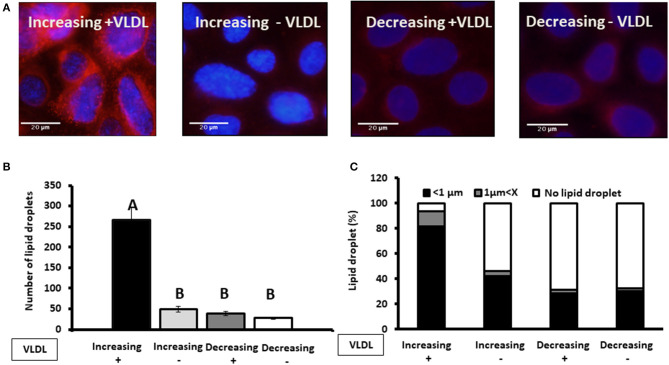
The effect of progesterone on the lipid droplet number is VLDL dependent. Mammary epithelial cells (MECs) were incubated with increasing (0.75, 2.5, and 5 ng/ml) or decreasing (5, 2.5, 0.75 ng/ml) progesterone concentration, with the presence or absence of VLDL. After incubation, nucleus was stained with DAPI (blue) and lipid droplets in Nile red (red). Lipid droplets were counted and measured. (A) Representative figures from increasing and decreasing progesterone concentration treatments with and without VLDL. The most pronounced lipid droplets were found in the increasing progesterone treatment, in the presence of VLDL. Differences between increasing and decreasing treatments were only presented if VLDL was added to the culture medium. (B) Average number of lipid droplets by treatment per field; n = 5 fields with 24–50 cells per field and 3 replicates per treatment. Highest number of lipid droplets was recorded when MECs were treated with increasing progesterone concentration and with VLDL. Different letters indicate differences between treatments (p ≤ 0.0001). (C) Cells were divided into three phenotypes according to the largest lipid droplet measured: cells with large lipid droplets (x > 1 μm, gray), cells with small lipid droplets (x < 1 μm, black), and cells without lipid droplets (white). The difference between treatment in the distribution of cells among 3 phenotypes was tested with χ2-test. When VLDL was excluded from the culture medium, no differences between cells incubated with increasing or decreasing progesterone levels were found (p ± 0.0001).